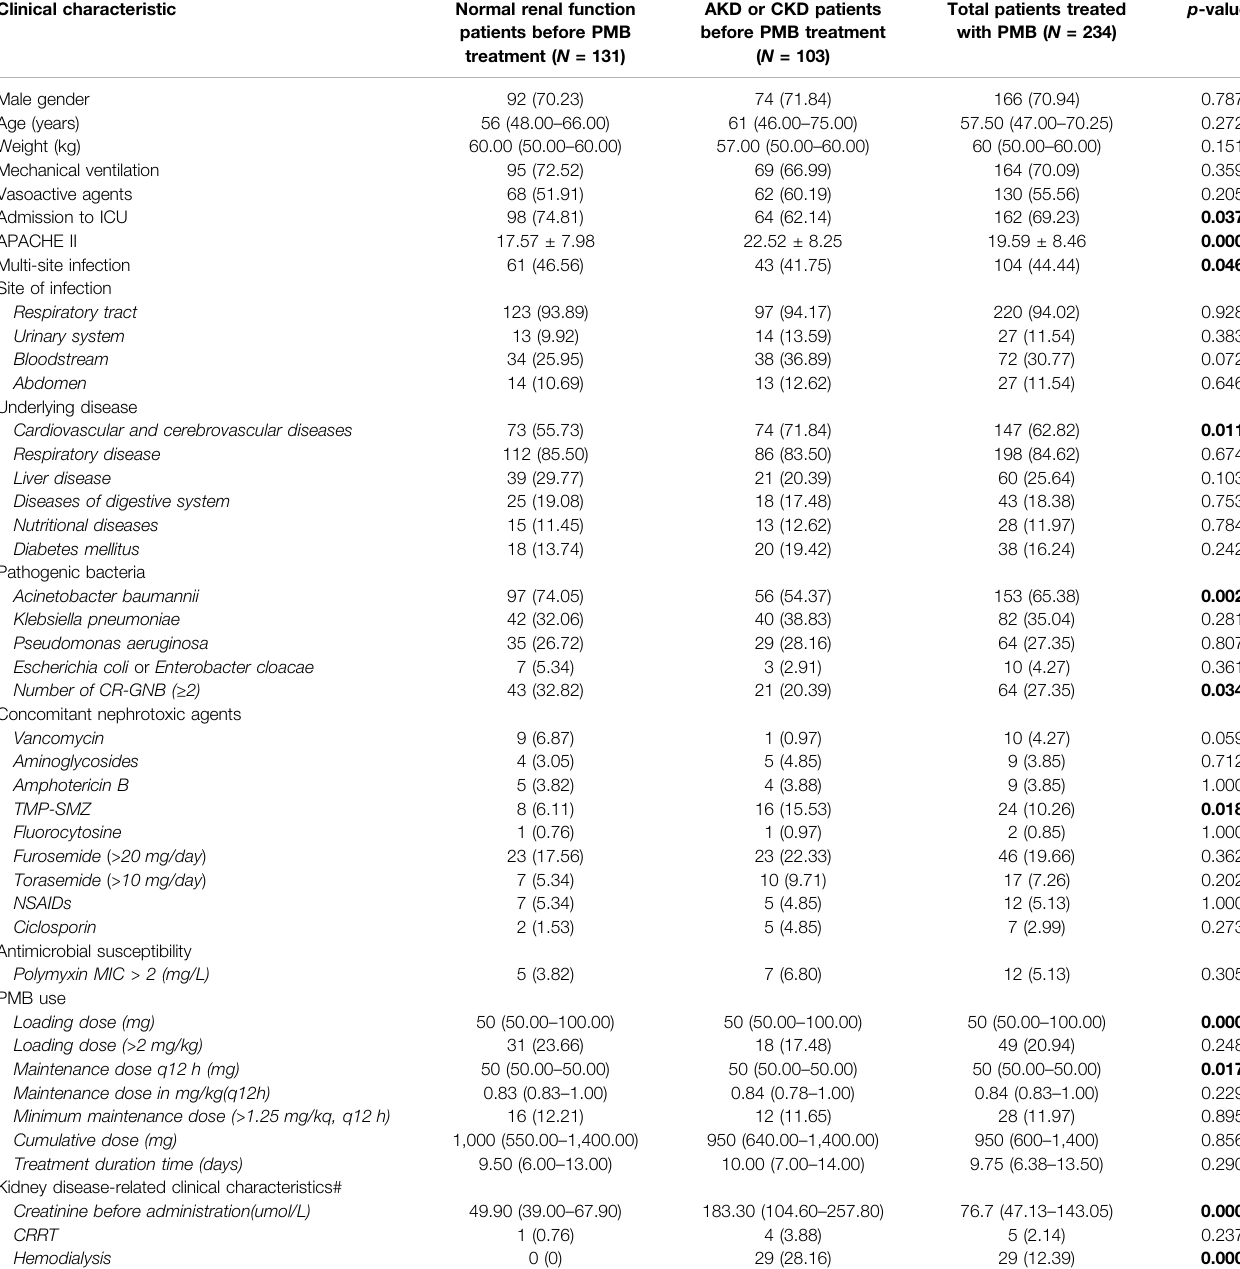
TABLE 1 | Demographics and clinical characteristics of the study